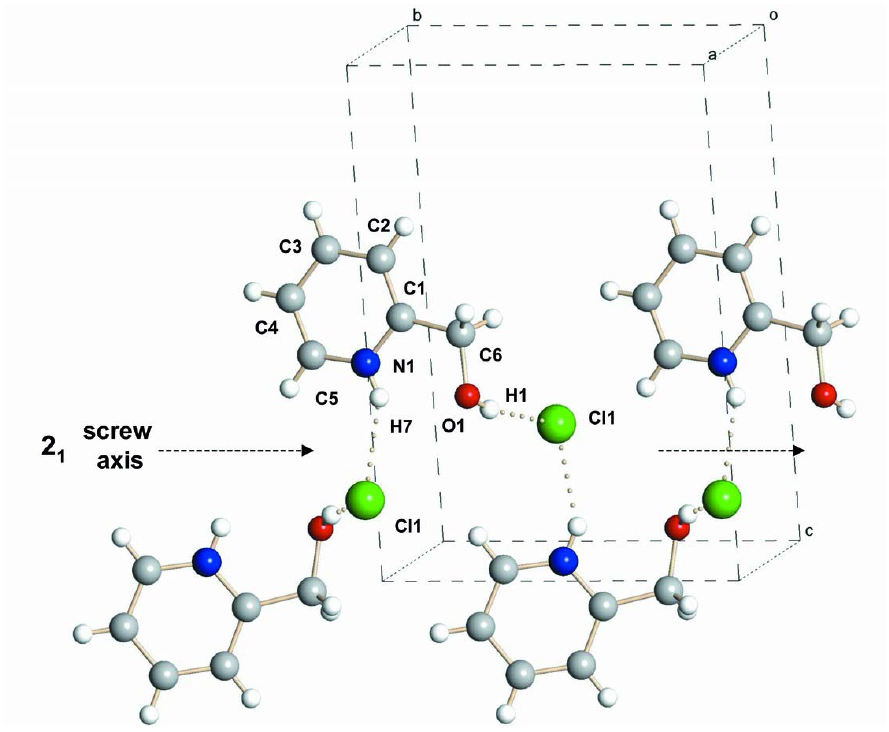
Figure 2 Packing of the title compound on the b-c plane illustrating the NH—Cl—OH intermolecular chain interaction which proceeds parallel to the b axis via the 2